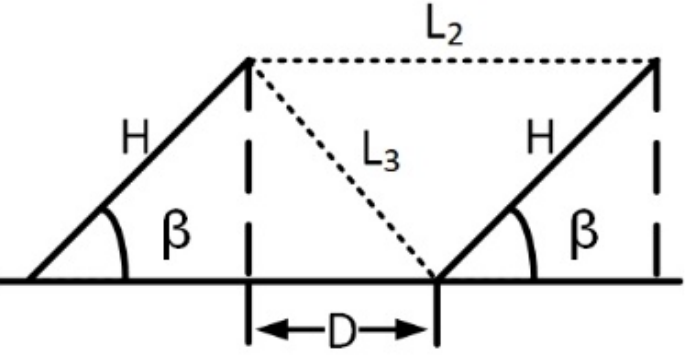
Figure 4. Multiple rows of collectors, H , deployed on a horizontal plane.